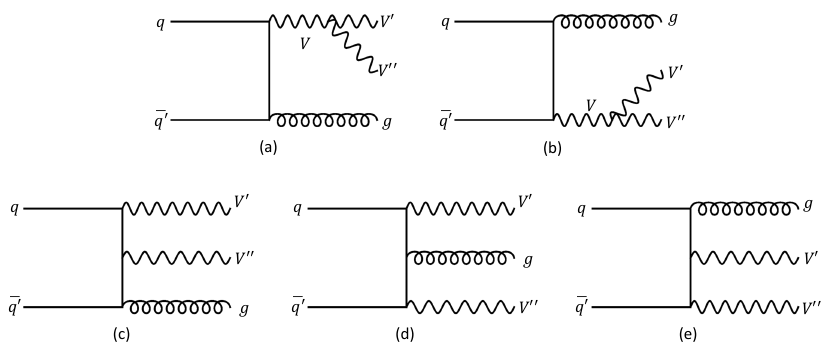
Figure 6. Diagrams (a) and (b) are the Fixed order equivalent channels for showering a q ¯ q → V + Jet process with a single-step V → V 0 V 00 branching. For the cases involving W + W − pairs in the final-state, diagrams (c), (d) and (e) must also be included to preserve gauge invariance. However, the contributions of these channels can be suppressed by introducing angular separation cuts ∆ R > 1 . 0 and ∆ R < 1 . 0 . Additionally, to ensure a clean branching signature, W + ,W − W ± ,Jet